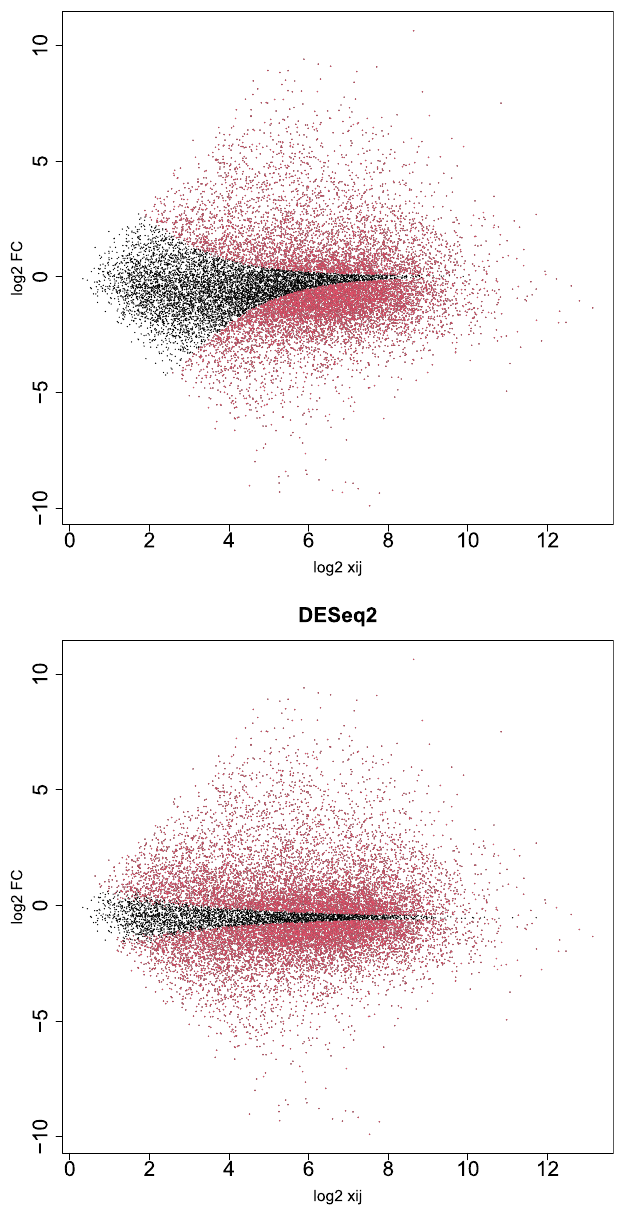
Figure 8. MAPlot with selected genes colored in red Upper: PCA-based unsupervised FE with optimized SD, lower: